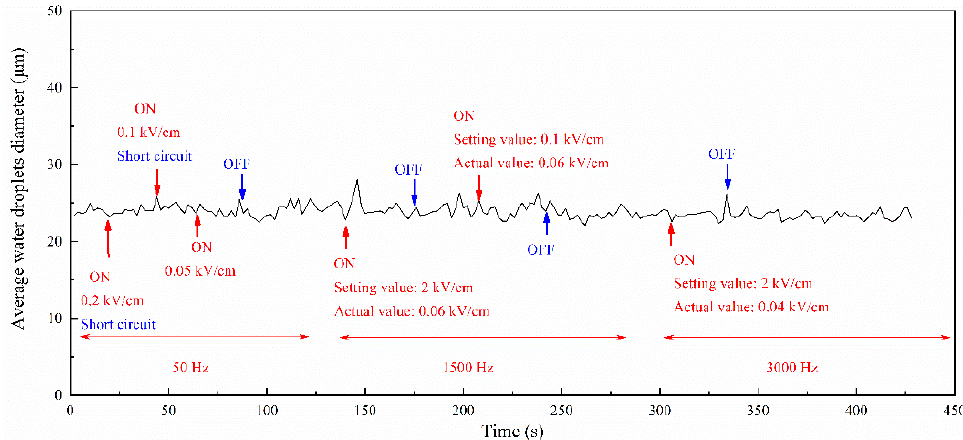
Figure 21. Variations of average water droplet size under different electric field parameters (water content 40%).